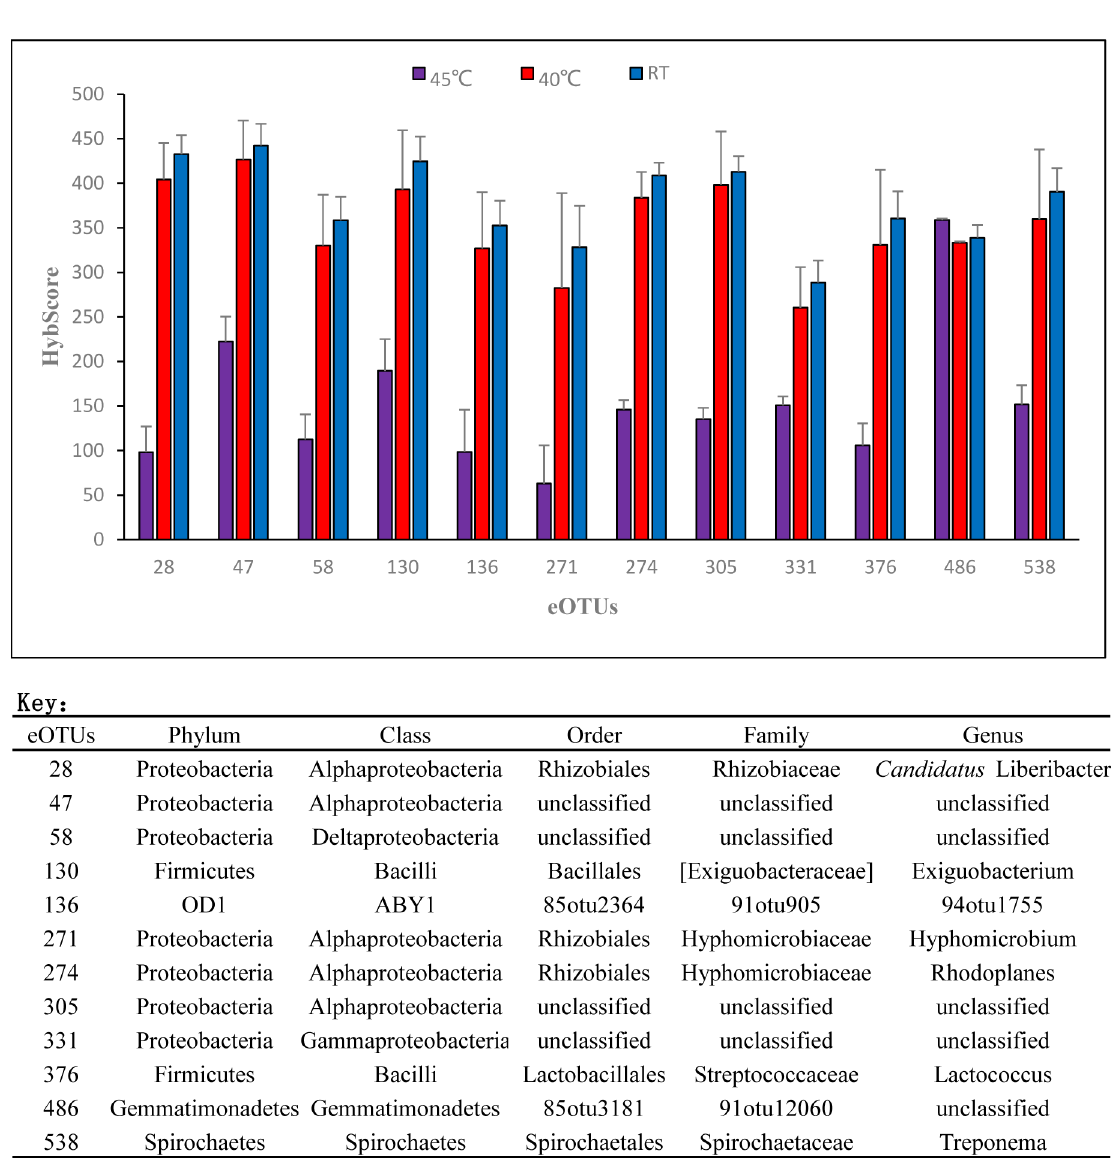
Fig 3. Phylochip TM G3 Hybscore for 12 of 48 taxa selected by Filter-5 in the HLB-affected citrus treated with thermotherapy at 45°C, 40°C or room temperature (RT). These 12 taxa were significantly different ( P < 0.05) in response to thermotherapy. The error bars indicate standard